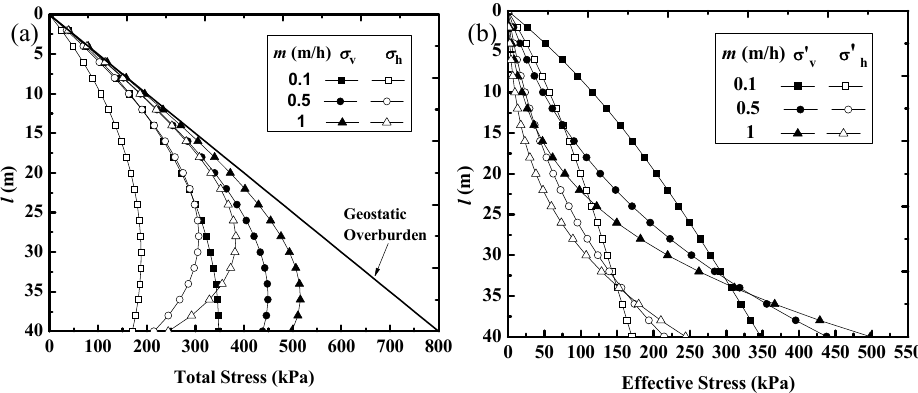
Figure 7. Distribution of the horizontal and vertical total ( a ) and effective ( b ) stresses with different filling rate m along the full height of the backfilled stope when the deposition ceases, predicted by the proposed solution (Equations (28)–(31)) by considering H = 40 m, B = 6 m, c v = 5 m 2 /h, γ = 20 kN/m 3 , γ w = 10 kN/m 3 , ϕ ’ = 20° and K = K a .